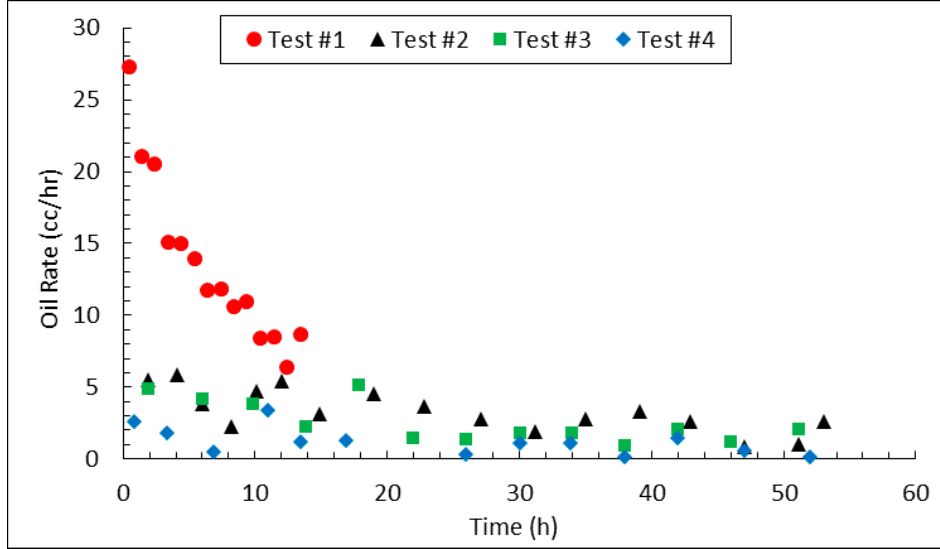
Figure 11. Actual transition region thickness values for the experimental cases presented by Ma et al. [3].